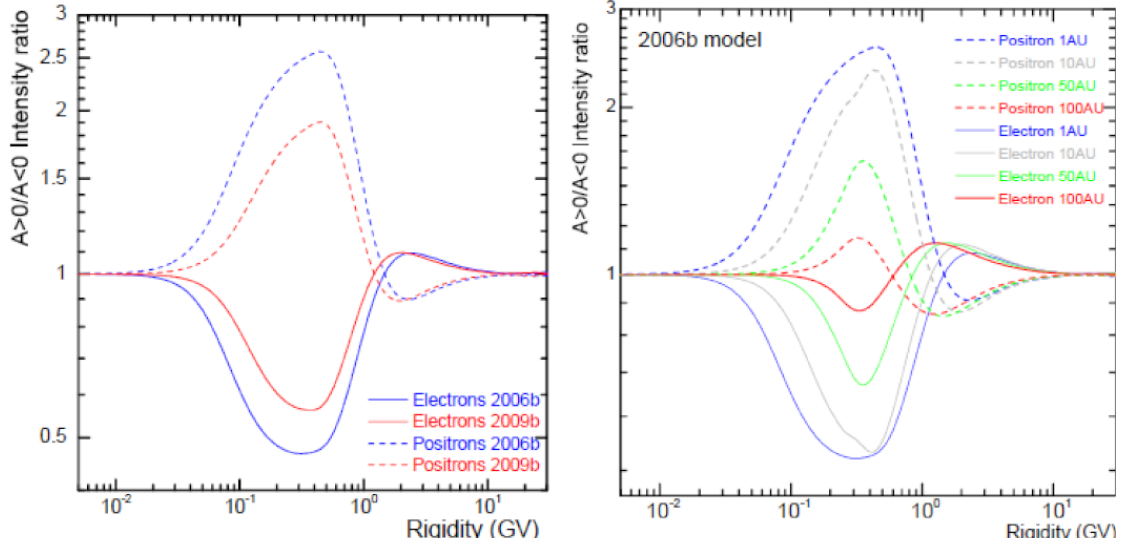
Figure 10. ( Left panel) Predicted drift effects at Earth for positrons and electrons in terms of the intensity ratios between A > 0 and A < 0 drift cycles. This relates to what is shown in Figure 9 for positrons, again displayed for modulation conditions applicable to 2006b and 2009b. ( Right panel) Drift effects for positrons and electrons at 1 AU, and predicted for 10 AU, 50 AU and 100 AU in the heliospheric equatorial plane. In this latter case modulation conditions for 2006b only are simulated.